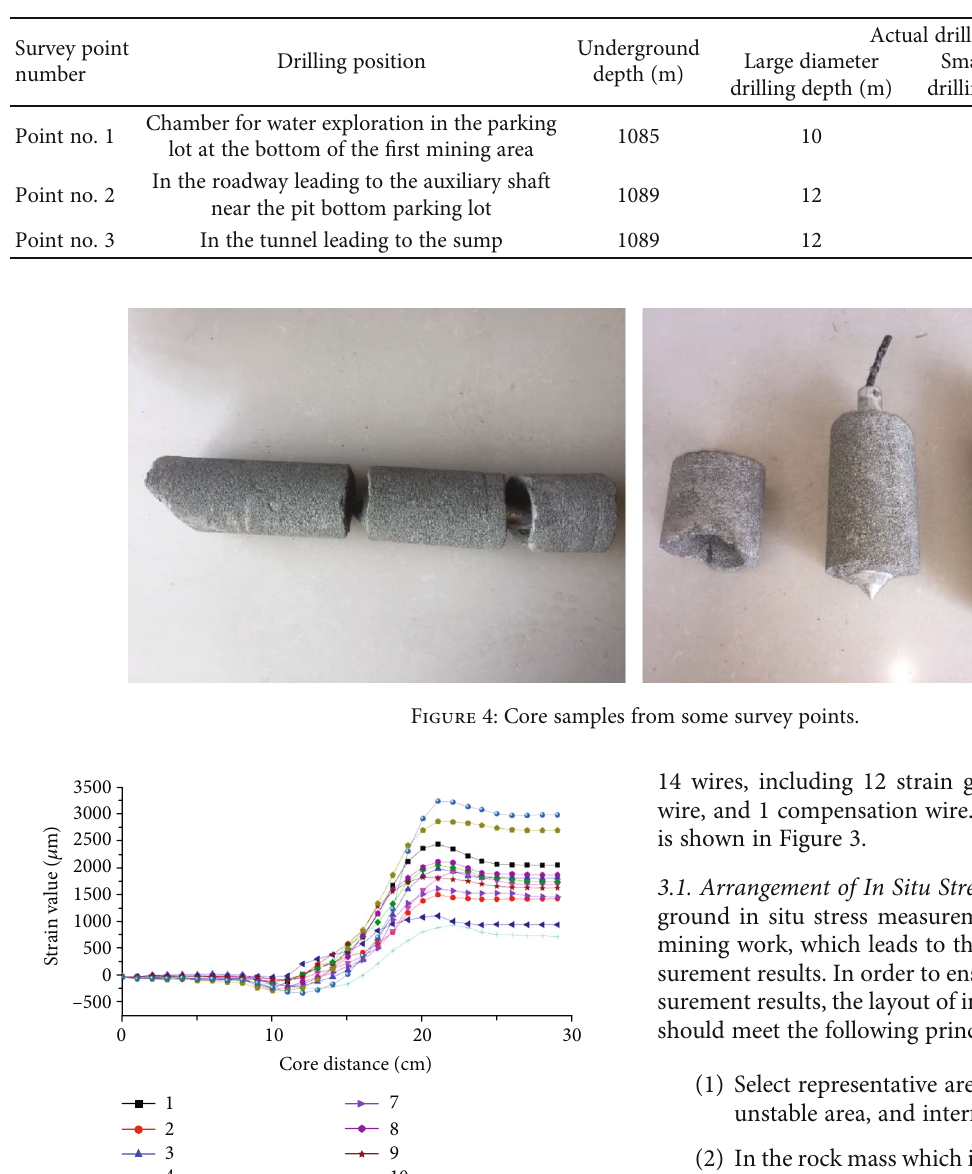
Table 1: Drilling design parameters of each measuring point.